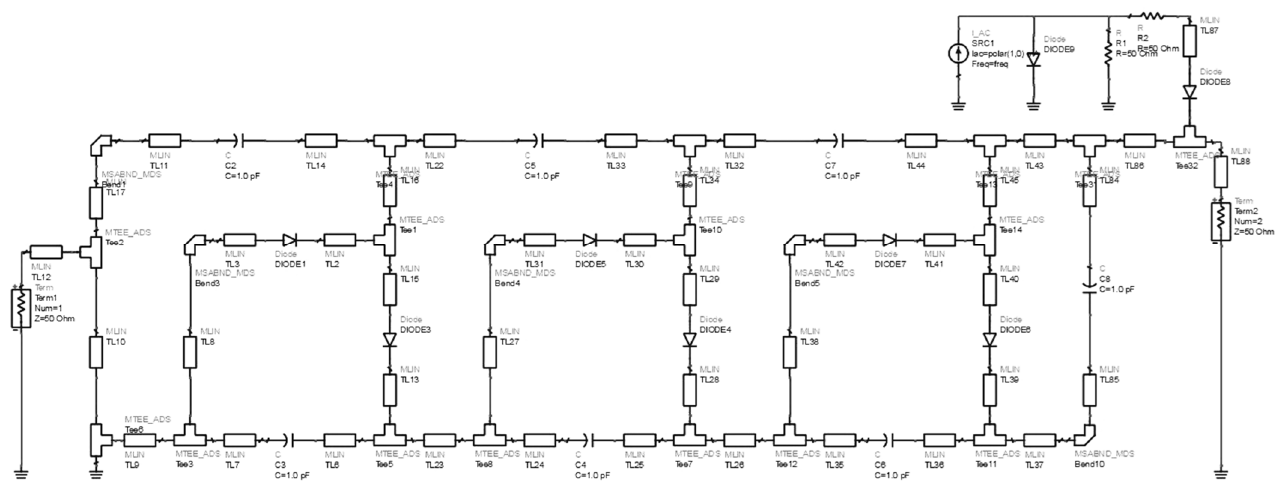
Figure 7. Configuration of the 3-stage voltage doubler circuit.